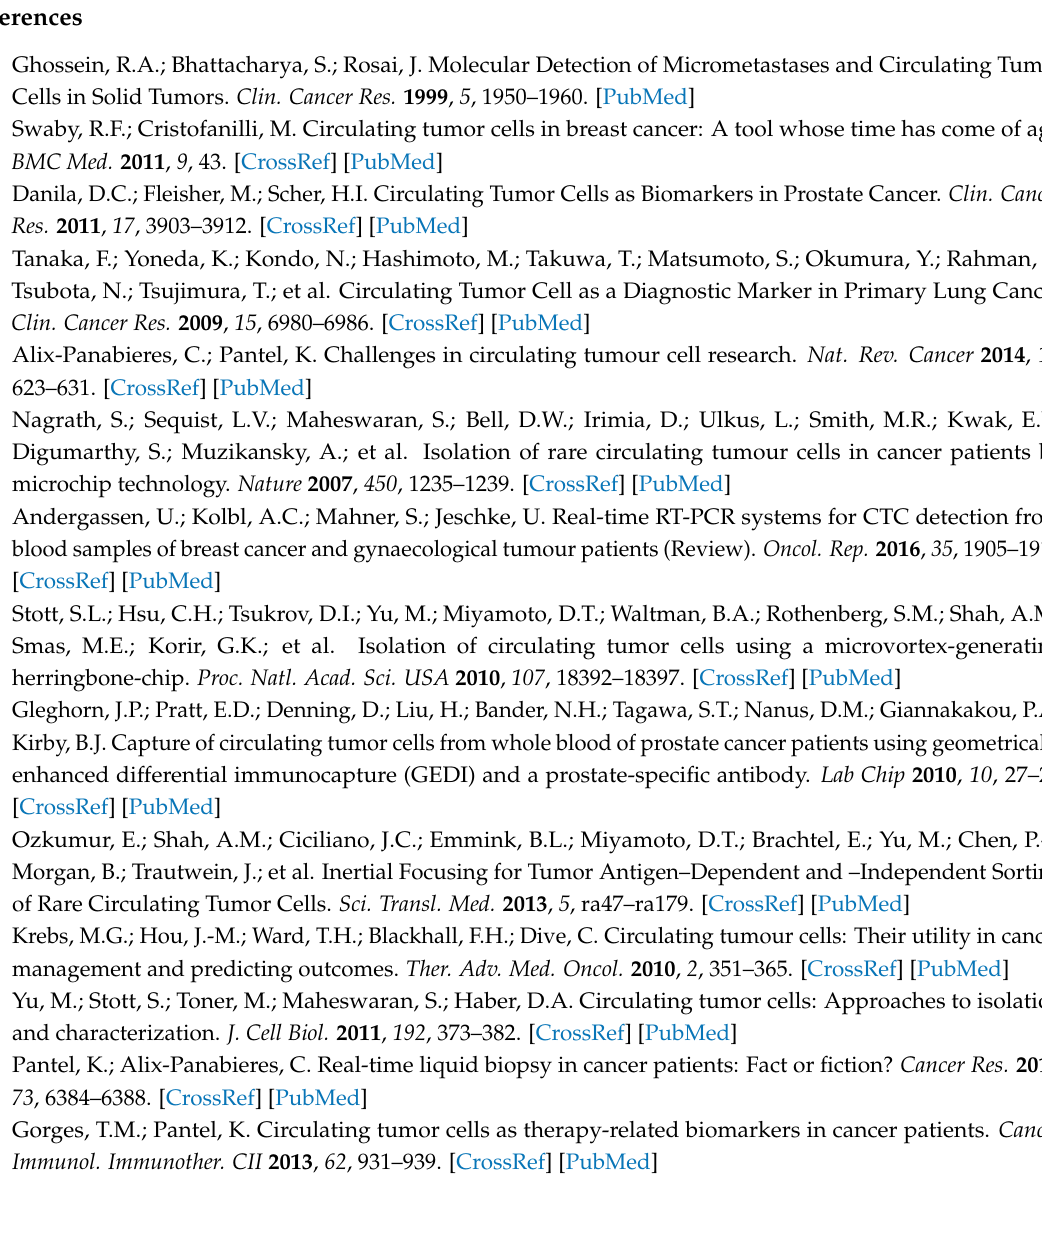
Figure S1: Reference SERS spectra of (a) HeLa, (b) PC3, and (c) leucocytes placed directly on SERS substrate, Figure S2: SERS spectra of (a) leucocytes, (b) HeLa, and (c) PC3 cells recorded from different spots (ca. 100) within the same sample. The excitation wavelength was at 785 nm, laser power was 5 mW, and the acquisition time was 60 seconds, Figure S3: (a) First three PC (PC-1, PC-2, and PC-3) scores plot of 3D-PCA calculated for narrow range (700–750 cm − 1 ) and (b) loadings plot of the first principal component showing the most prominent marker band at 723 cm − 1 ,Table S1: The sizes of blood components, based on data from Handin et al., Table S2: The RSD of the selected intensities of SERS signals of leucocytes, HeLa, and PC3 cells recorded from 1000 different spots within the same